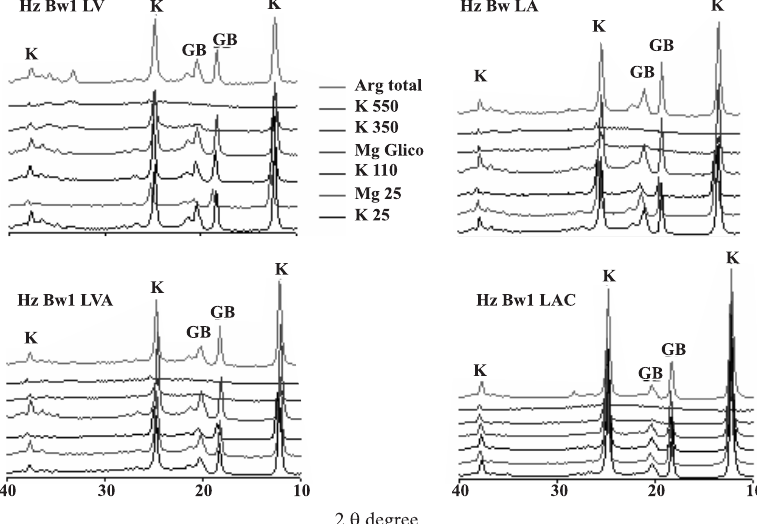
Figure 2. Mineralogy of clay iron-free fraction of the Bw horizons of pedons of the toposequence, where K: kaolinite and